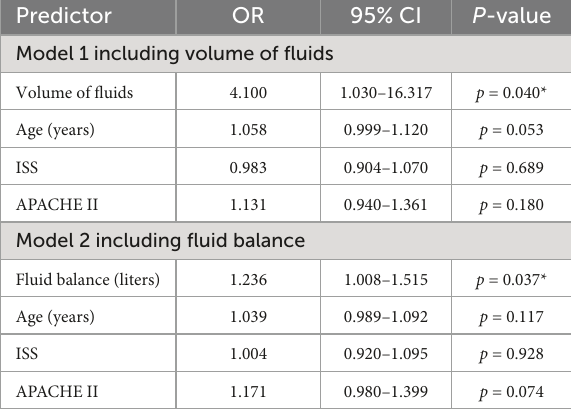
In a multivariable logistic regression analysis volume of the infused fluids and the fluid balance were positively associated with mortality (OR = 4.10; 95% CI = 1.030–16.317 and OR = 1.236; 95% CI = 1.008–1.515, respectively, Table 2 ). For other factors analyzed (age, ISS, APACHE II score) the association was not detected. Additionally, volume of fluids was negatively correlated with number of ventilator free days and fluid balance was negatively correlated with ventilator free days, and positively correlated with complications and time until ready for discharge from ICU ( Table 3 ). Furthermore, volume of fluids and/or fluid balance was correlated with volume of blood products transfused, INR, and APTT ( Table 3 ). Comparison between survivors and non-survivors